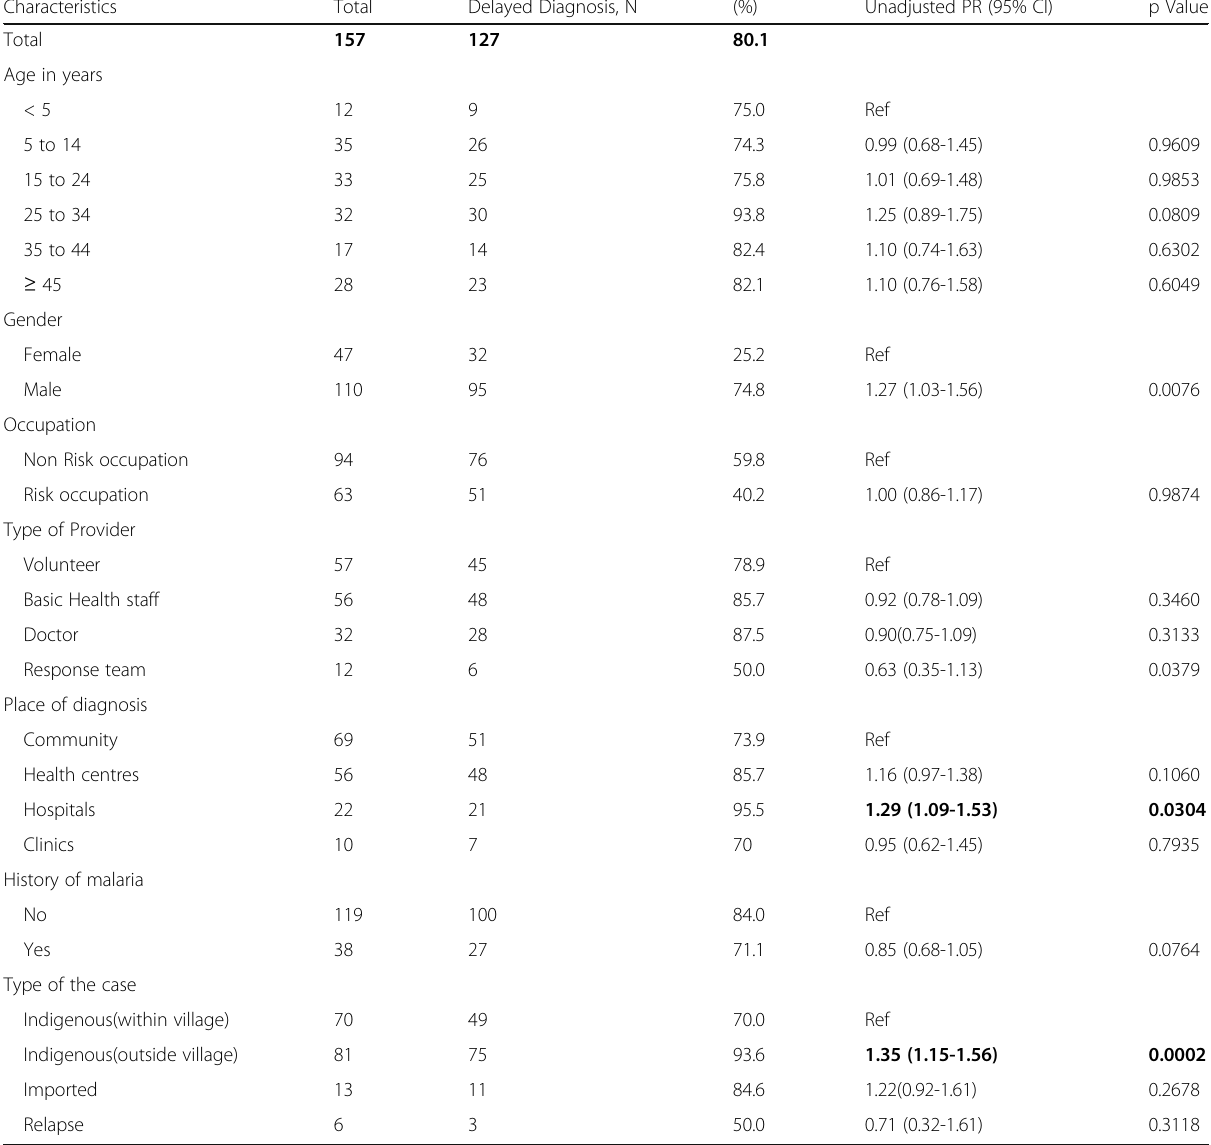
Table 3 Factors associated with delayed diagnosis (>24 hours of symptoms) among investigated malaria cases, N= 157